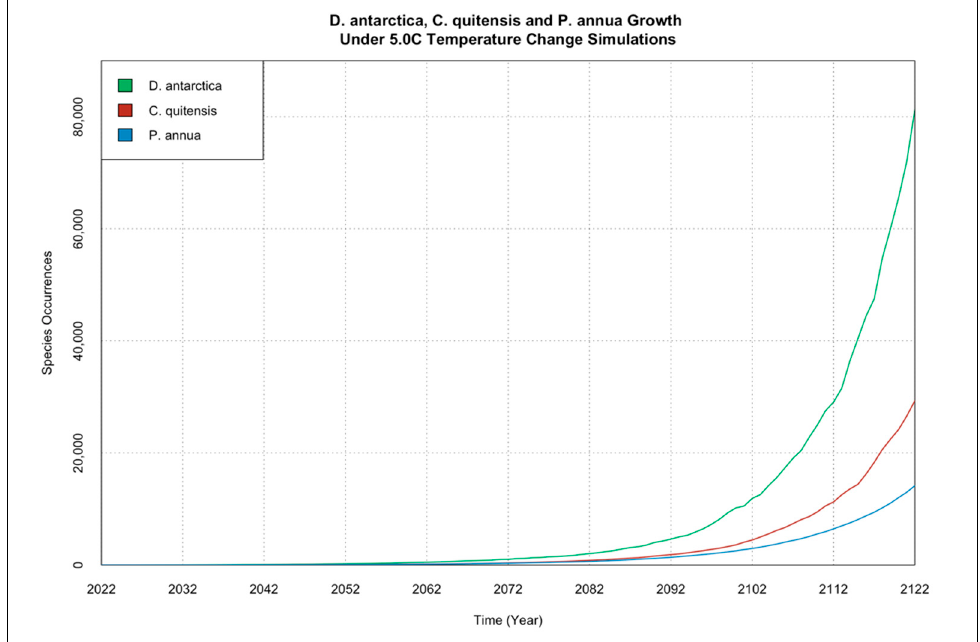
Figure 8. D. antarctica, C. quitensis and P. annua Occurrences under 1.6 °C Temperature Change Simulation.